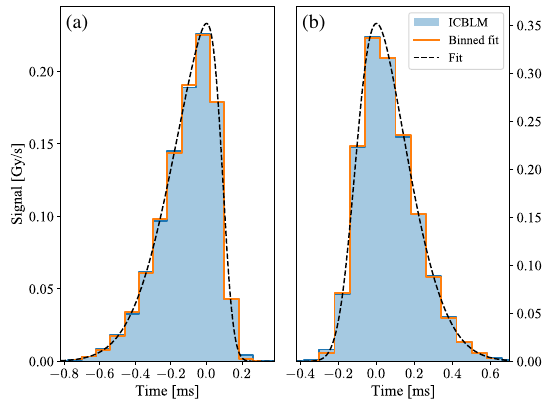
FIG. 2. Example of measured UFO events with negative skewness (a) and positive skewness (b). The fit for the underlying inelastic collision rate is shown, as well as the resulting binned signal. Their skewness γ is − 0 . 87 and 0.68 respectively.